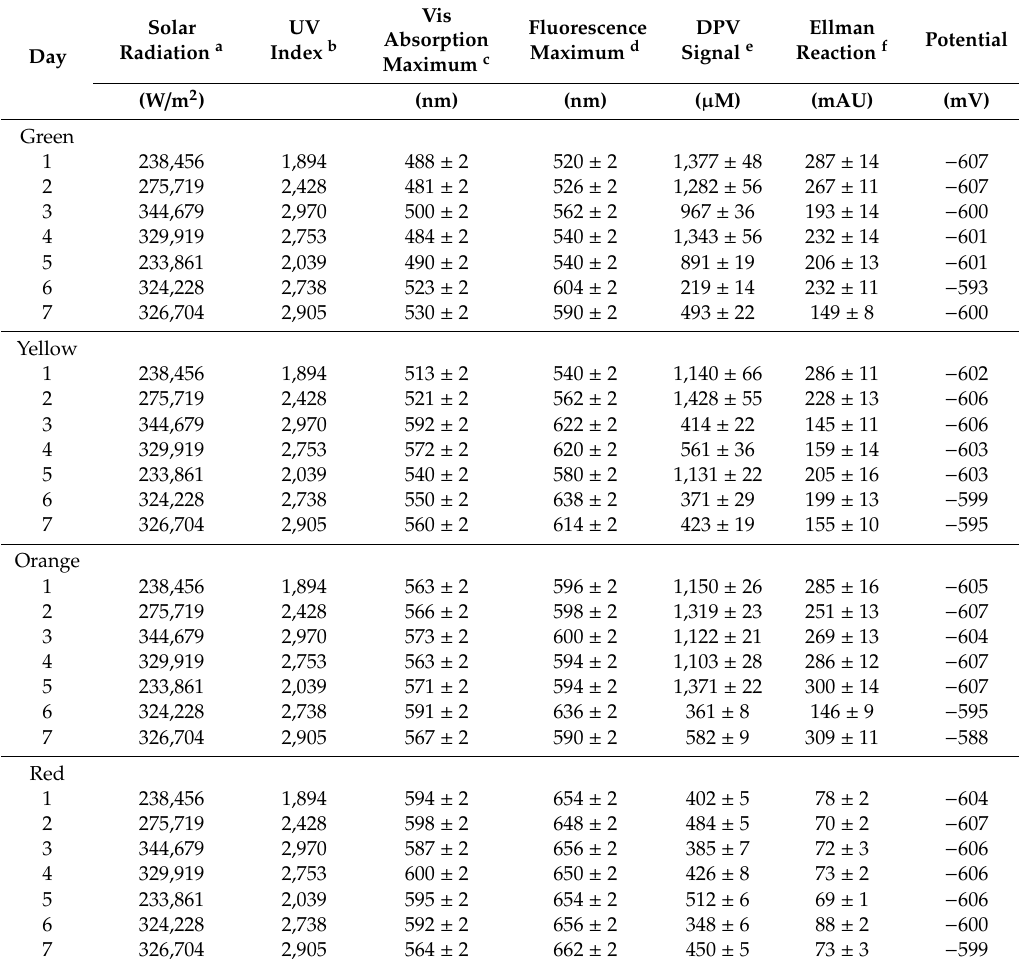
Table 3. Measured parameters of green, yellow, orange and red CdTe QDs exposed to outdoor UV radiation for seven consecutive days in